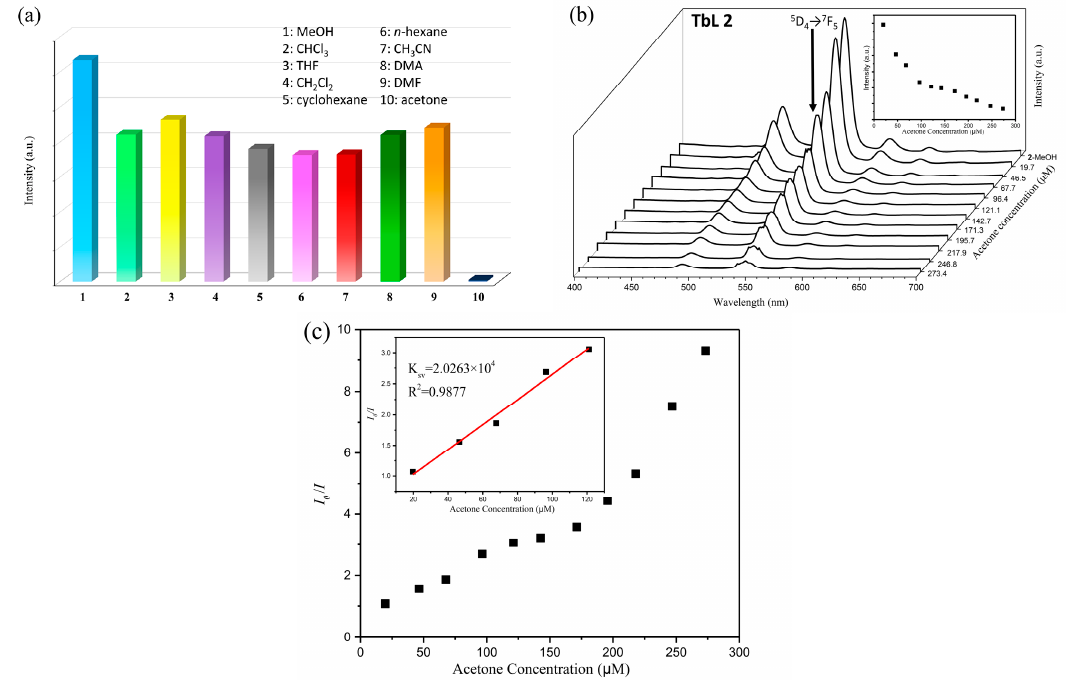
Figure 4. ( a ) Comparisons of the luminescence intensity of TbL 2 in different solvent suspensions at room temperature ( λ ex = 332 nm). ( b ) The luminescence emission spectra titration of TbL 2 -dispersed in methanol with the addition of different concentrations of acetone at room temperature ( λ ex = 332 nm). ( c ) Stern–Volmer plot of I o / I versus the concentration of acetone in the 2 -menthanol suspension (insert: enlarged view of a selected area).